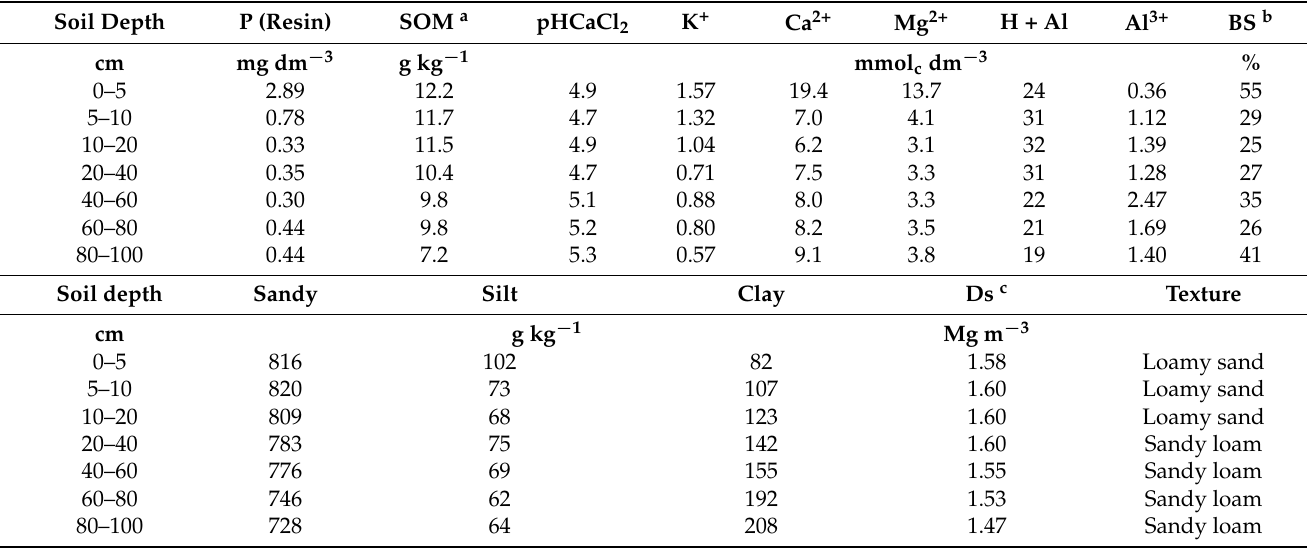
Figure 1. ( A ) The experimental area in São Paulo state, Brazil. ( B ) Sampling locations: 0.0 (planting row), 2.0, 4.0, and 6.0 m from the Eucalyptus trees. ( C ) Monoculture pasture. ( D ) Rainfall and maximum and minimum temperatures in the experimental area, 2013–2015. Table 1. Chemical and physical soil characteristics of the studied Arenic Hapludult prior to the start of the experiment in 2009.